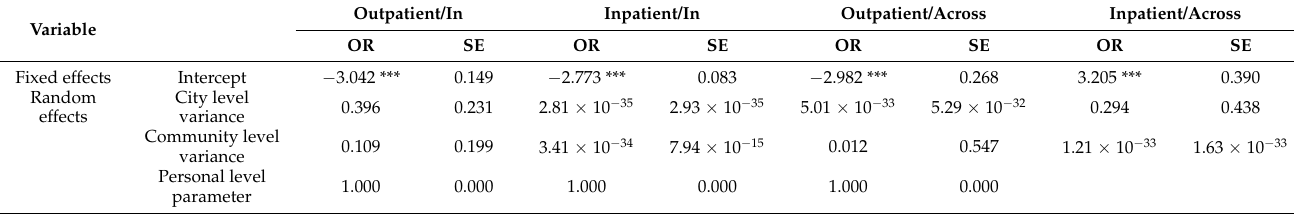
Table 3. Three-level empty model of influencing factors of health service utilization between the matched groups. Outpatient/In Inpatient/In Outpatient/Across Inpatient/Across Variable OR SE OR SE OR SE OR